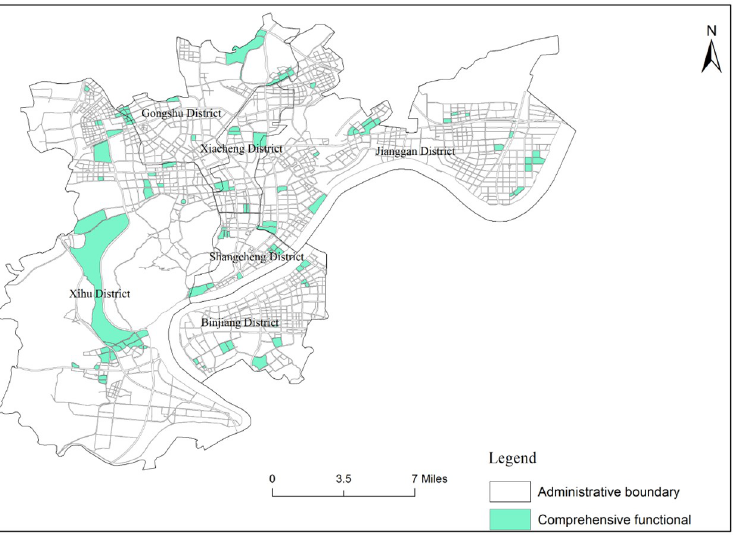
Fig 6. Distribution map of comprehensive functional areas in the central city area of